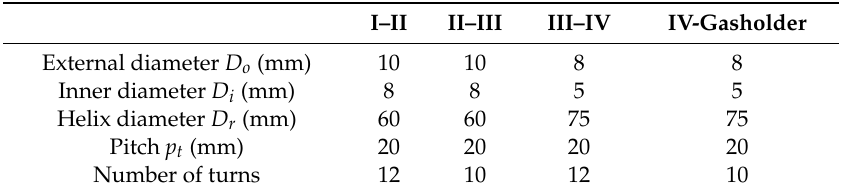
Table 10. Specifications of the spiral cooling